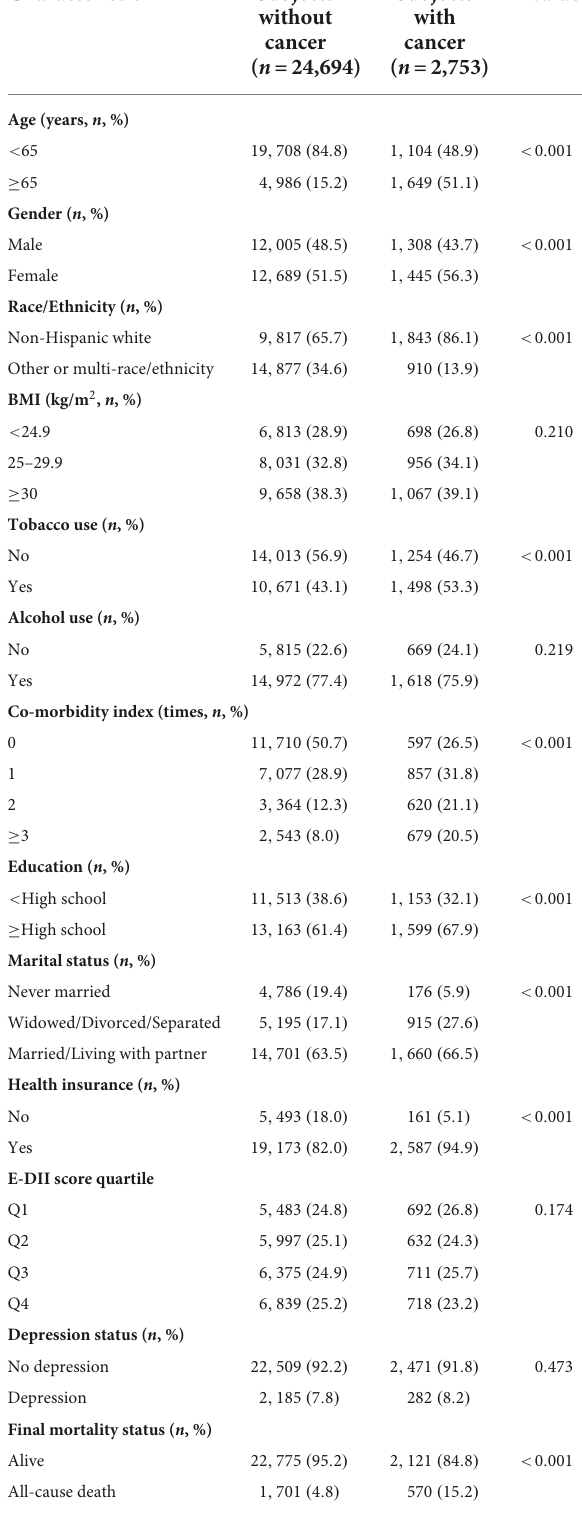
TABLE 1 Population characteristics by cancer status in NHANES